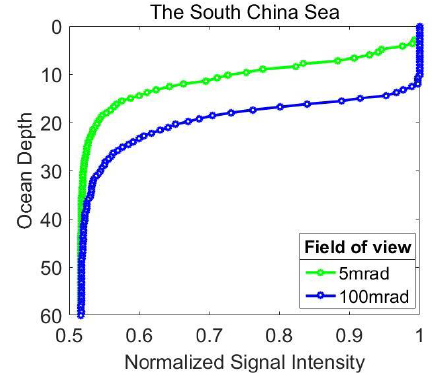
Fig 4. Lidar attenuated backscatter in the narrow field of view (5mrad) and wide field of view